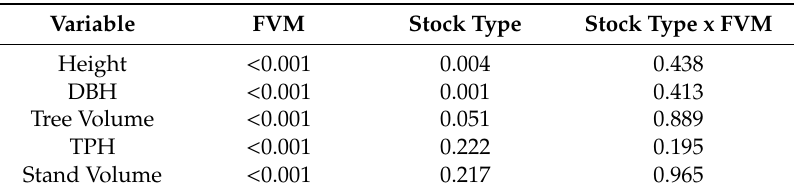
Table 4. Results of ANOVA tests for the e ff ects of vegetation management regimes (FVM) and seedling stock type on Douglas-fir mean height, diameter at breast height (DBH), individual tree volume, trees per hectare (TPH), and stand volume atyear 10. Significant e ff ects are denoted in bold. Treatment descriptions are provided in Table